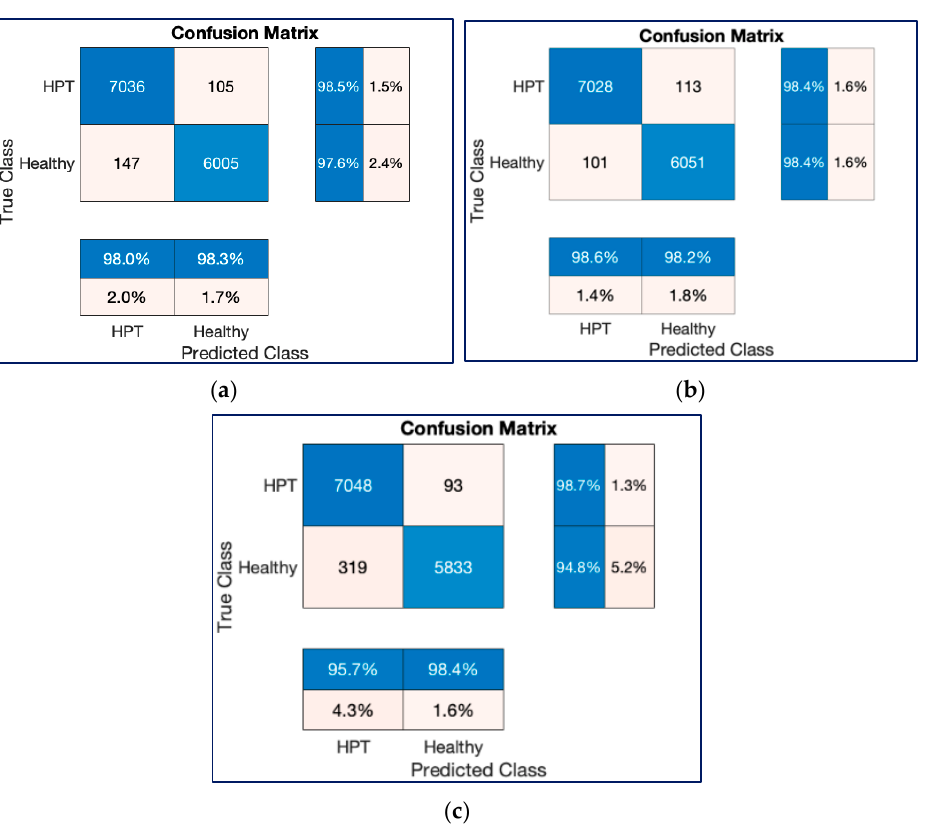
Table 3. Average 10 ‐ FCV performance evaluation metrics for 132,968 spectrogram images.